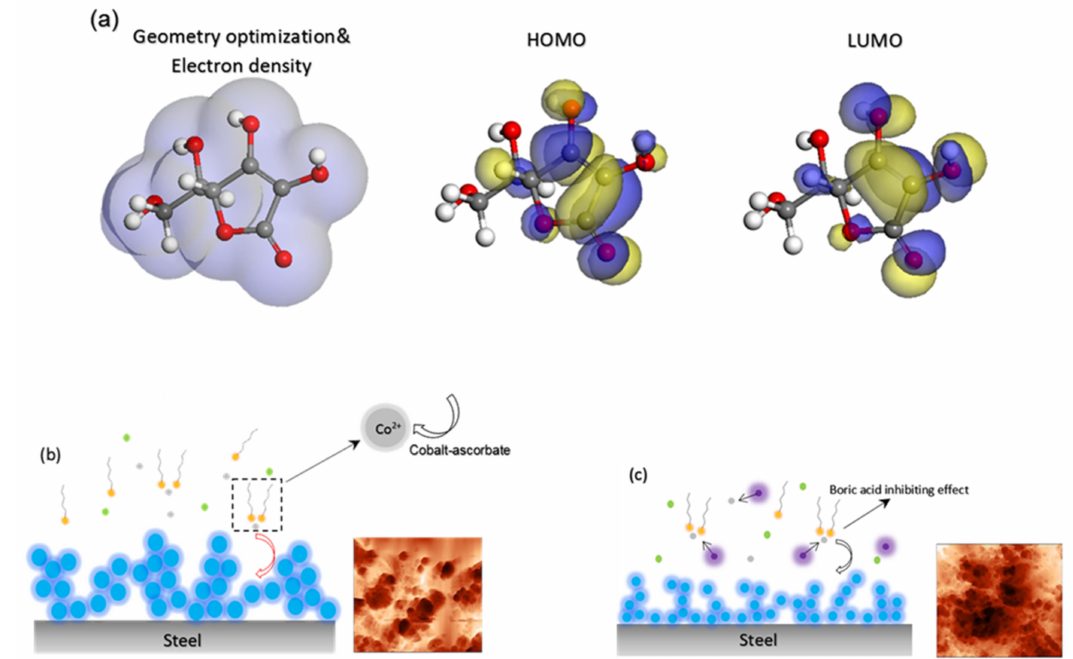
Figure 4. ( a ) Optimized geometry of ascorbic acid, highest occupied molecular orbital (HOMO) orbitals, and lowest unoccupied molecular orbital (LUMO) orbitals ( b ) schematic representation of ascorbic acid interaction with substrate and cobalt-ascorbate complex formation during electrocrystallization process, ( c ) crystal modifier action of boric acid molecule on crystal growth